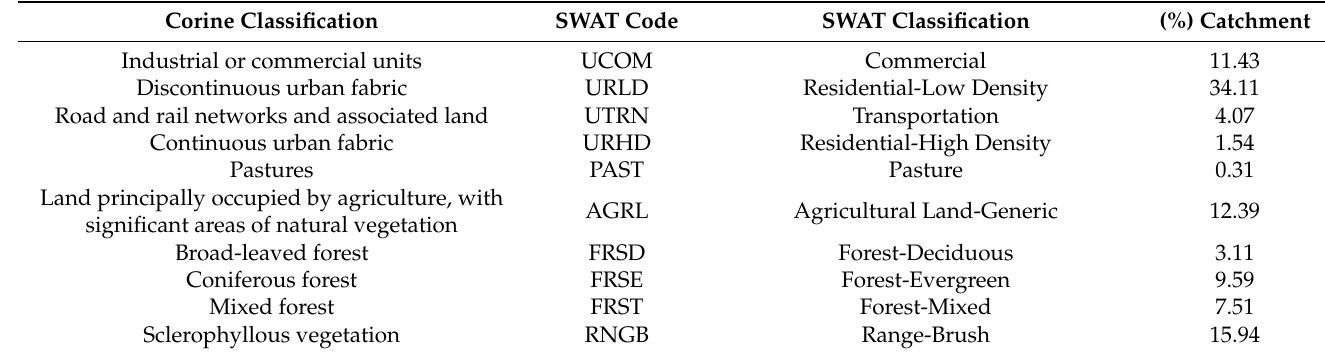
Table A1. Land use categories of the study area at catchment level.